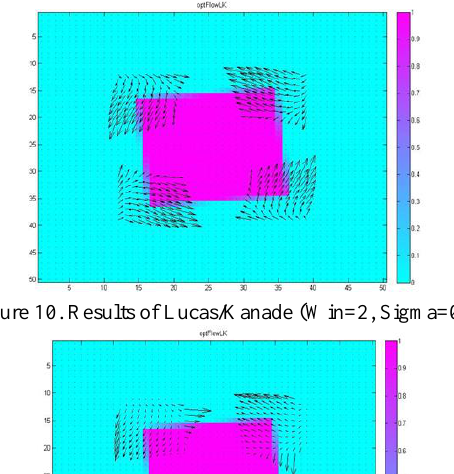
Figure 7. Results of Horn and Schumck (α=2)